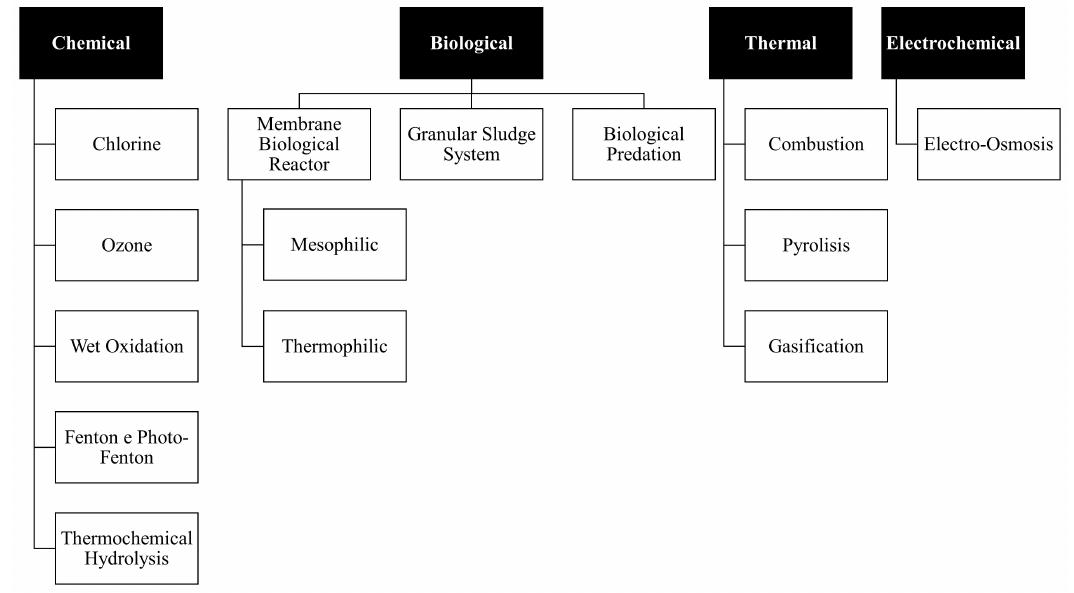
Figure 4. Suitable advanced treatments available for the minimization of SS production are shown.